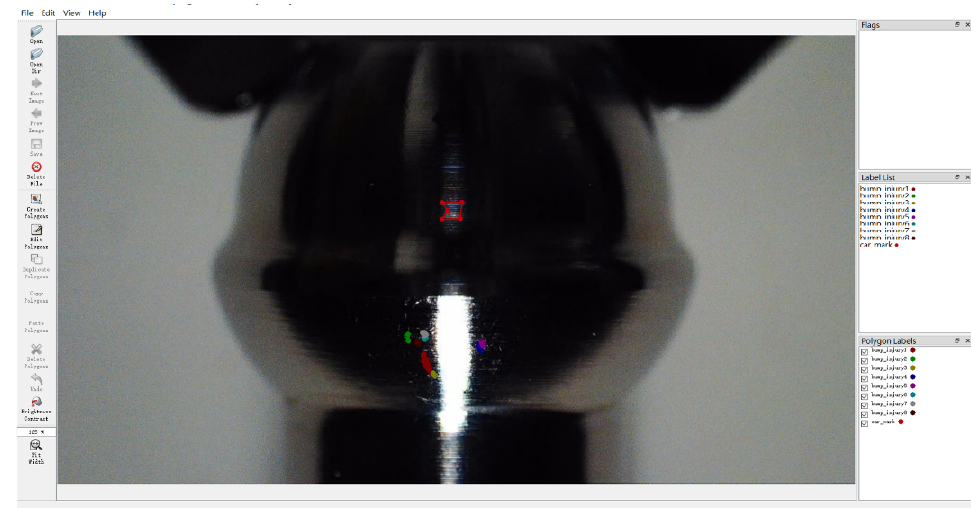
Figure 11. LabelImg of automotive engine parts data.